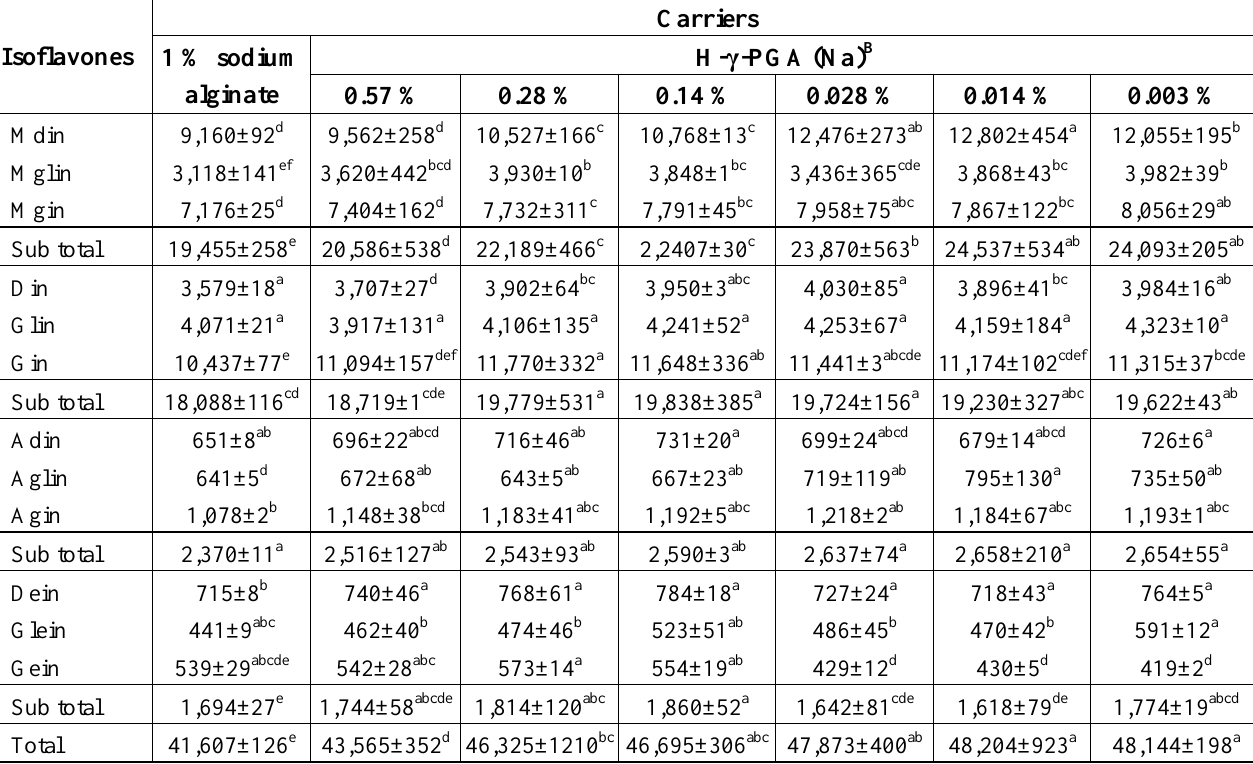
Table 4. Isoflavone contents ( µ g/g) A in the freeze-dried powder with H- γ -PGA (Na) B or sodium alginate as carrier C .